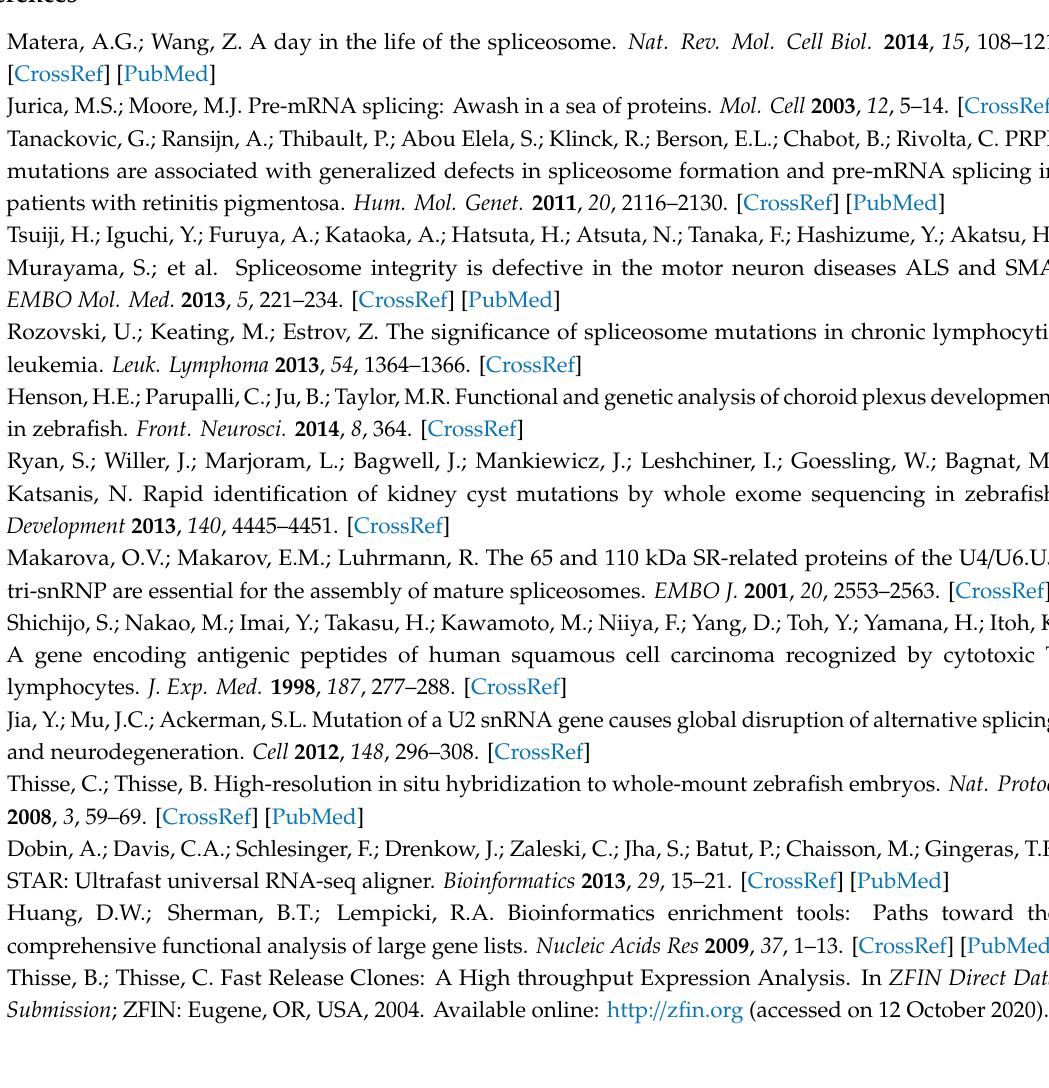
Figure S1: deltaC expression is disordered in cp27.5 mutants; Figure S2: Scatter plot of log2 ratio of exon junction di ff erential usage vs. log2 RPM of exon junctions with di ff erentially used exon junctions in red. File S1: RNA-Seq analysis from a zebrafish mutant in the gene sart1 (https: // figshare.com / articles / dataset